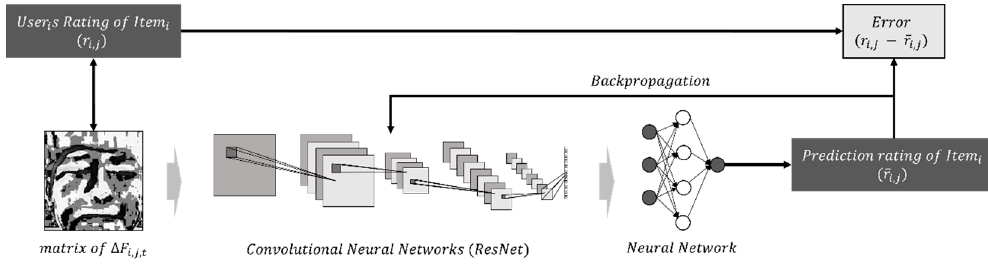
Figure 5. Changes in image t and image t − 1.